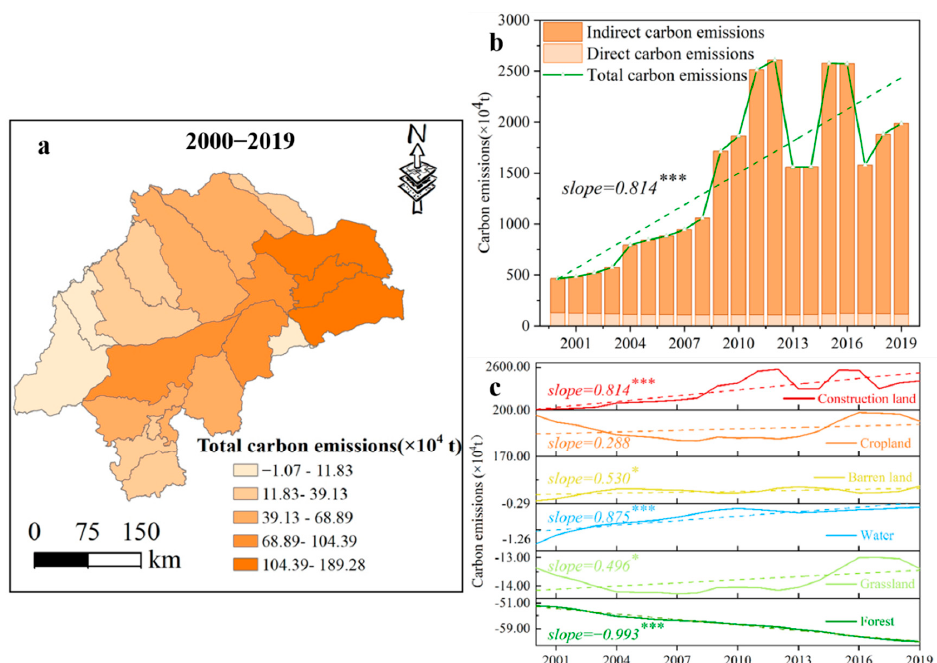
Figure 4. Changes in carbon emissions in the study area from 2000 to 2019. ( a ) The spatial distribution of the multi-year average carbon emissions; ( b ) the changes in the total carbon emissions; ( c ) the changes in the carbon emissions from the different land use types. Note: * denotes significance at the 0.05 level, and *** denotes significance at the 0.001 level.